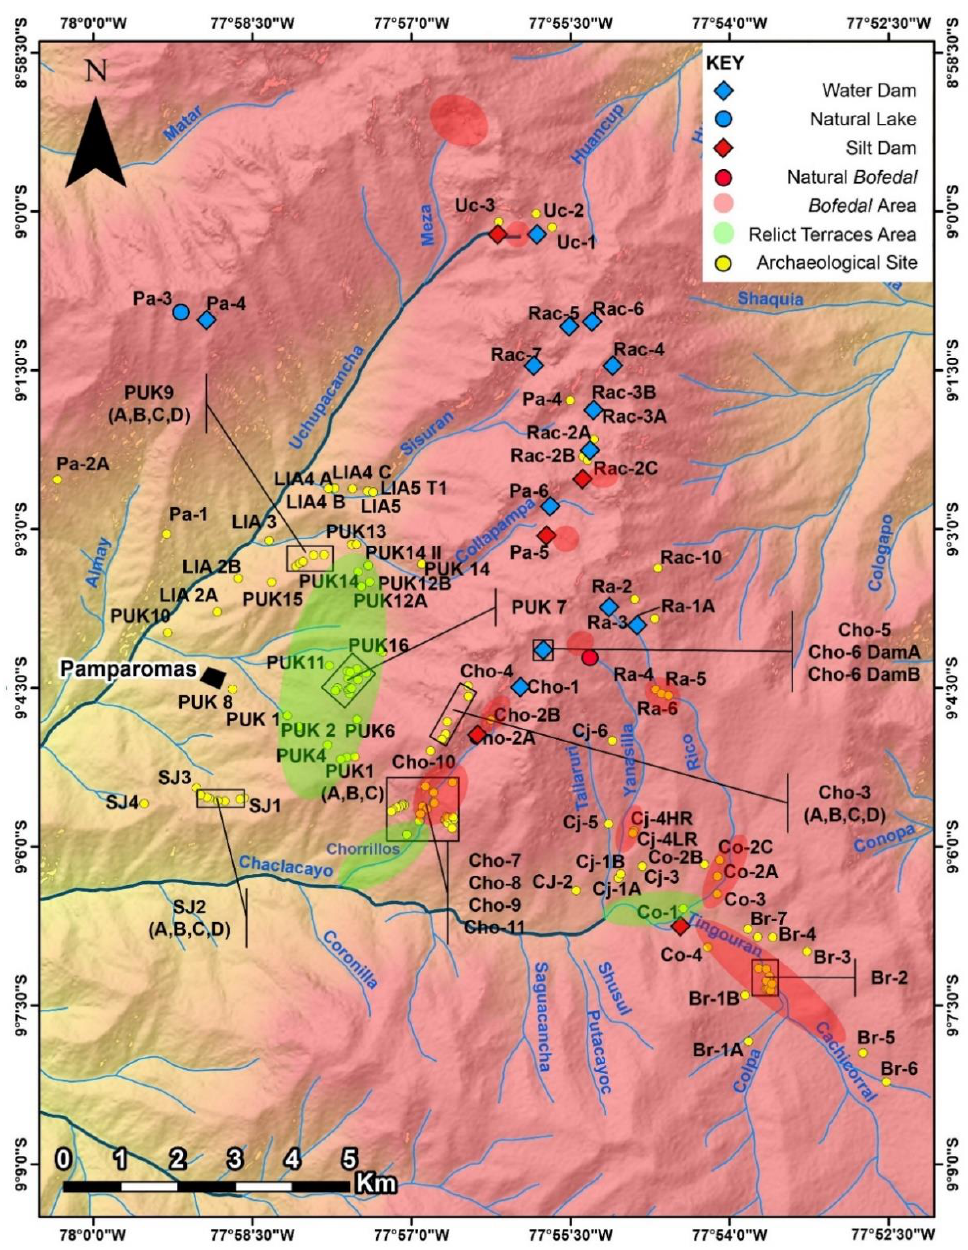
Figure 3. Map of the study area showing the location of hydrological features, including relict terrace areas and wetlands ( bofedal ).